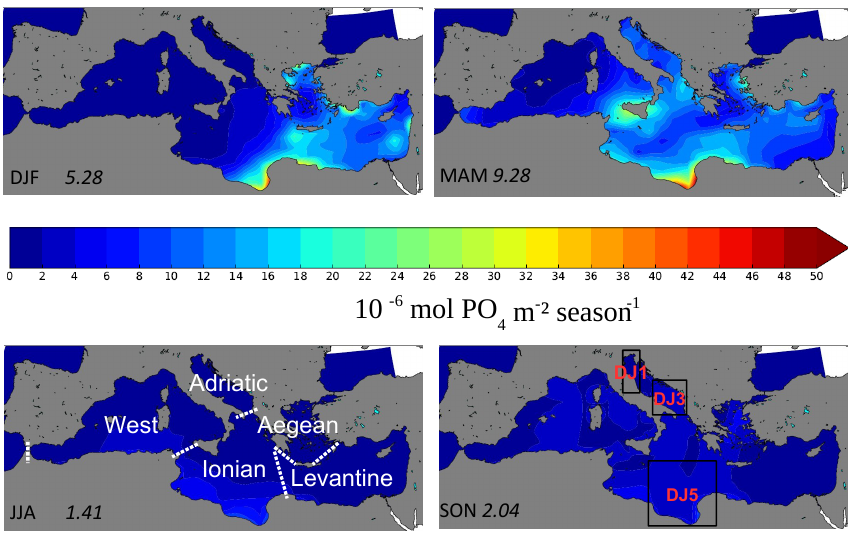
Figure 5. Total seasonal desert-dust-derived soluble phosphorus deposition (Pdust, in 10 − 6 molPO 4 m − 2 season − 1 ) over each season of the year 2005 (molar flux is calculated as mass flux/phosphorus molar weight) from the LMDz-INCA model. Numbers on the maps are the average seasonal deposition fluxes over the whole basin in 10 − 6 molPO 4 m − 2 season − 1 . In the Summer (JJA) deposition map, we display the different subregions referred to in the text. In the autumn (SON) map, we display subregions as defined in Manca et al. (2004): DJ1 is the north Adriatic region, DJ3 is the south Adriatic region and DJ5 is the south Ionian region.